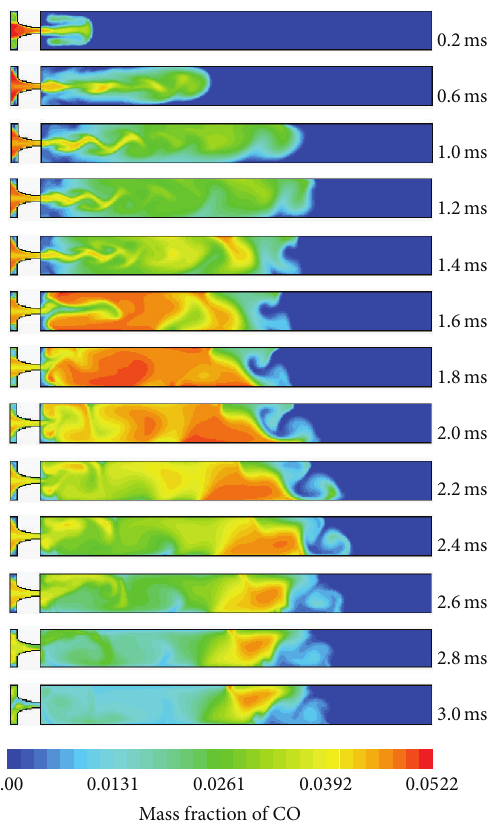
Figure 11: CH 3 mass fraction during methane-air combustion predicted using DRM19 mechanism.